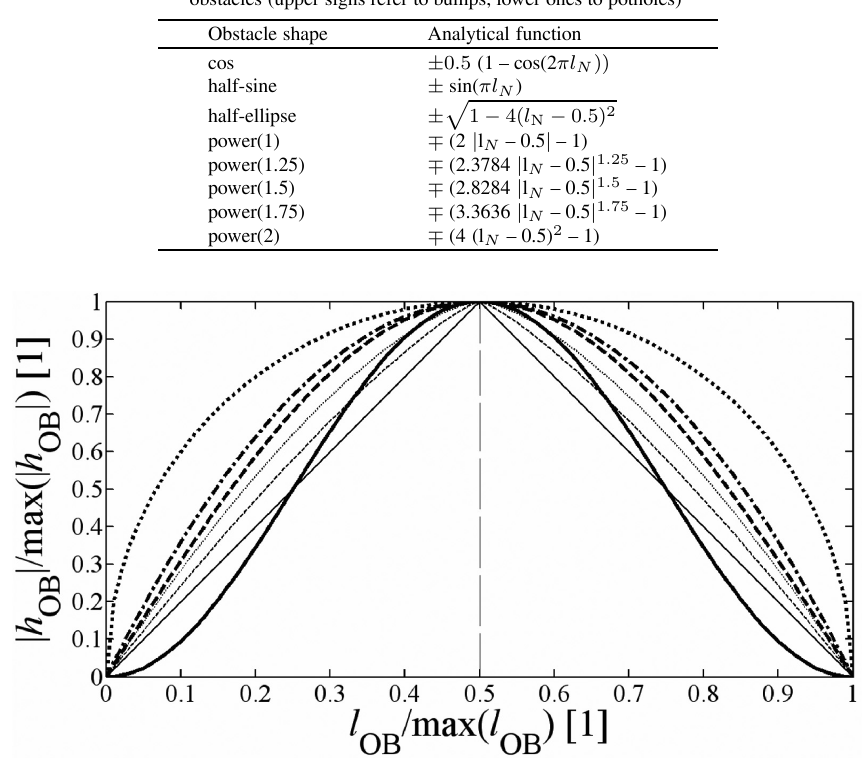
Fig. 2. Template of fi tting functions used for normalized bumps (cos ( ), half-sin ( ), parab ( • ), half-ellipse ( • • • ), power(1) ( ), power(1.25) ( − − ), power(1.5) ( · · ·